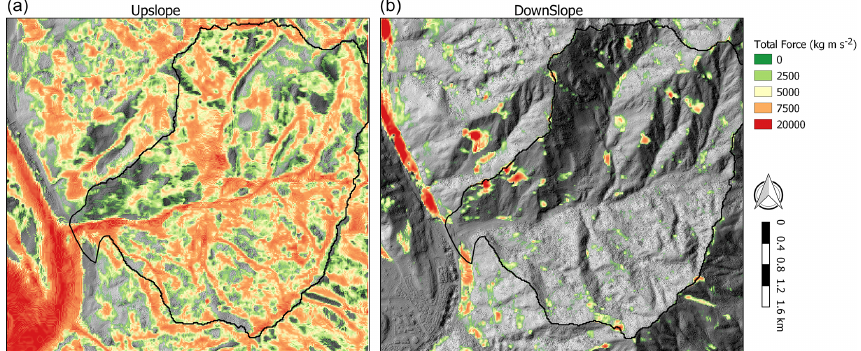
Figure 13. The upslope (a) and downslope (b) additional forcing that is estimated based on an iterative solution for subsurface force redis- tribution.